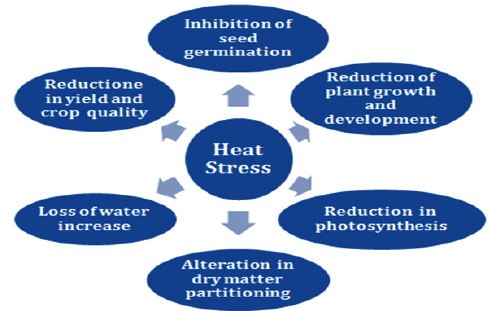
Fig. 1. Effect of heat stress on plant (Source: Adopted from Hasanuzzaman et al ., 2013)